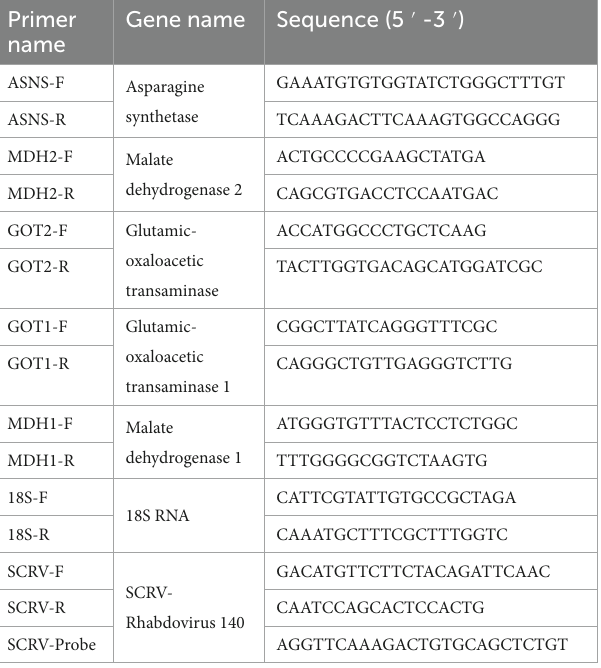
TABLE 2 The primers used in the